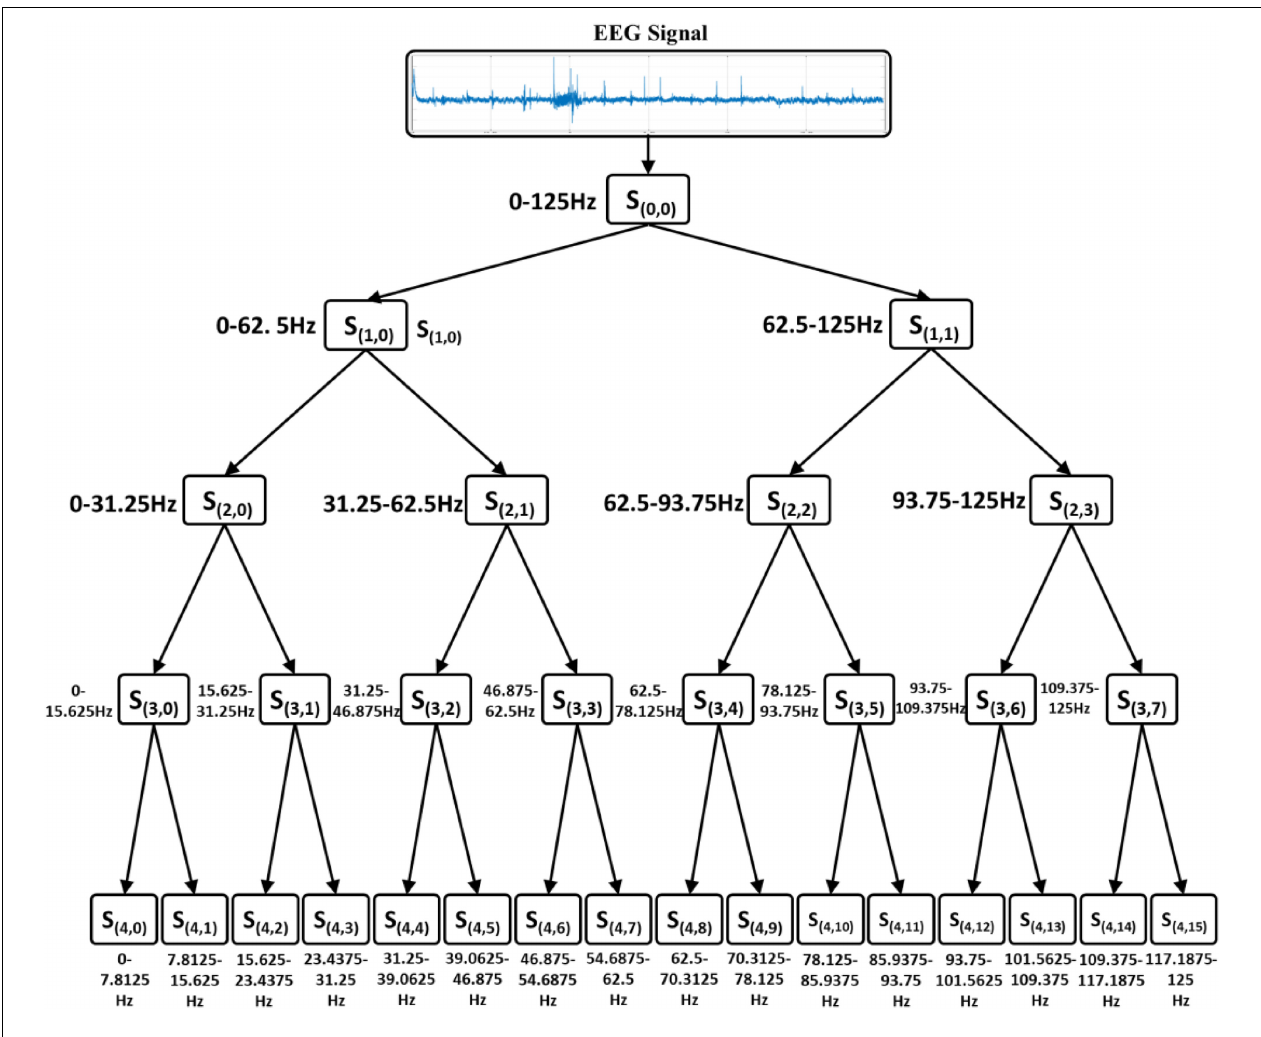
FIGURE 1 | Four-layer wavelet packet decomposition of EEG